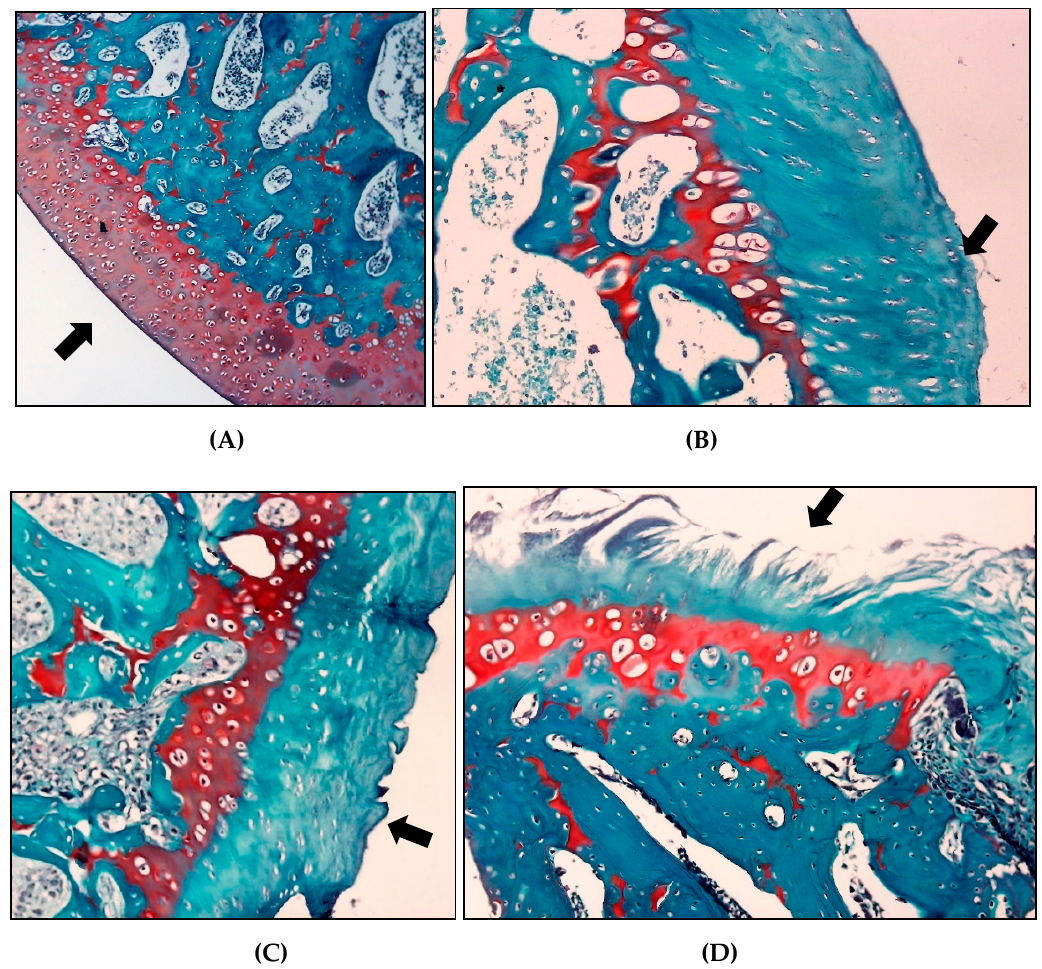
Figure 10. Effect of crude extract of S . dulcis on classification articular cartilage histology . ( A ) For articular cartilage, the score 0 represents the surface and morphology of intact cartilage (GS) (Figure 10A). ( B ) Score 1, an intact surface with superficial fibrillation (GSD) (Figure 10B). ( C ) For score 2 there is already a discontinuity of the articular cartilage (GM) surface (Figure 10C). ( D ) For score 4 (GSAL), the surface has vertical crack-like cracks with erosion areas (Figure 10D).